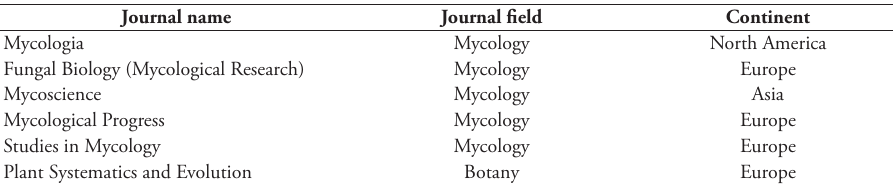
Table 1. The journals targeted for species descriptions